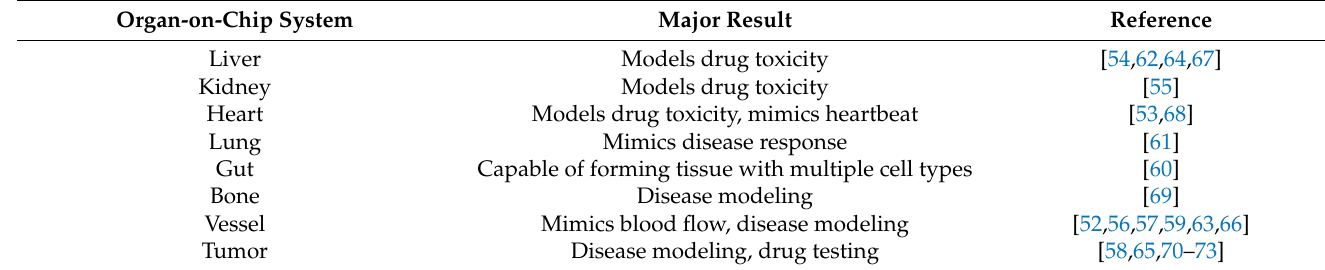
Table 3. Major results for